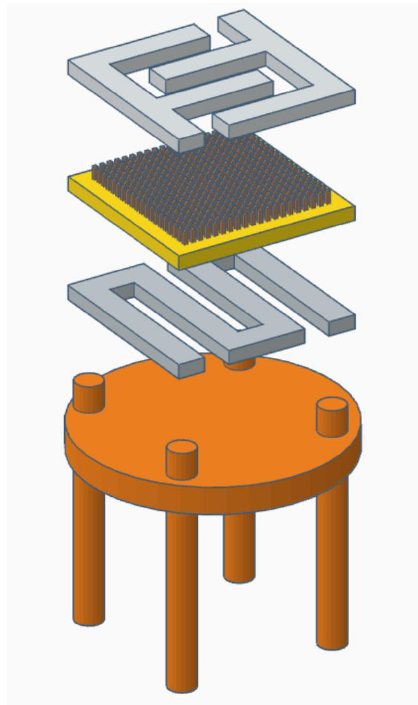
Figure 1. Scheme of the sensor architecture. From top to the bottom: two interdigited platinum electrodes (gray), the sensing material (dark gray), alumina substrate (yellow), platinum heather (gray), gold-coated “transistor outline” (TO-39) package (brown).